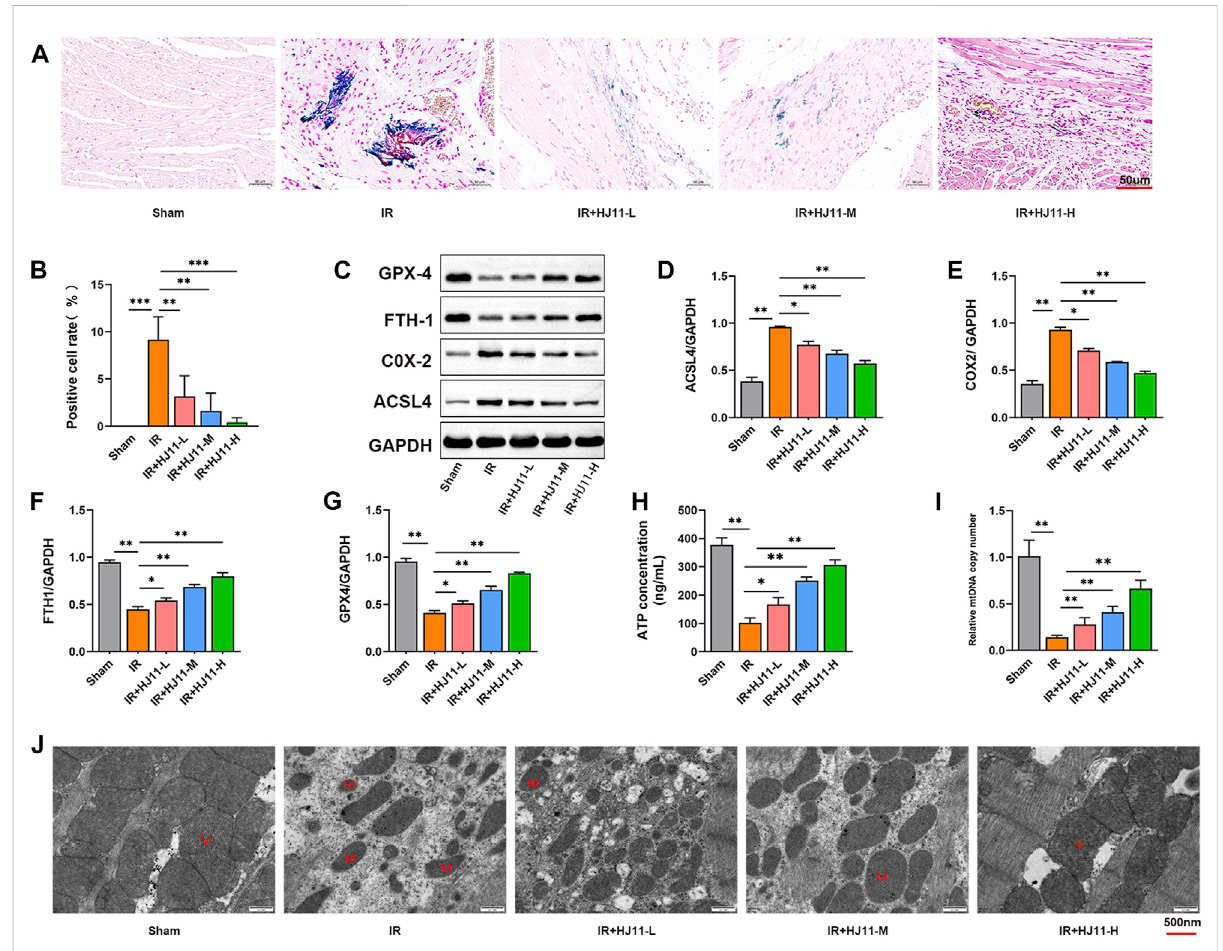
EffectsofHJ11decoctiononironionaccumulationandmitochondrialdamageinratswithmyocardialI/Rinjury. (A,B) Representativeimagesof Prussian blue staining and statistical analysis illustrating that HJ11 decoction attenuated iron accumulation in the myocardial tissues of rats with myocardial ischemia-reperfusion (I/R) injury. Scale bar: 50 µm. (C – G) Representative western blots for ferroptosis-associated proteins in the myocardial tissues of rats. Statistical analysis of western blots indicated that HJ11 decoction suppressed the expression of ACSL4 and COX2 proteins but promoted the expression of FTH1 and GPX4 proteins in the myocardial tissues of rats with myocardial I/R injury. (H,I) HJ11 decoction enhanced adenosinetriphosphate(ATP) and mitochondrial DNA (mtDNA) levels inthemyocardial tissues of rats with myocardial I/R injury. (J) Representative transmission electron microscopy images of mitochondria in the myocardial tissues of rats, indicating that HJ11 decoction alleviated mitochondrial damage in the myocardial tissues of rats with myocardial I/R injury. Scale bar: 500 nm * p < 0.05. ** p < 0.01. *** p < 0.001. Data are shown as mean ± standard deviation. N = 3 rats for each